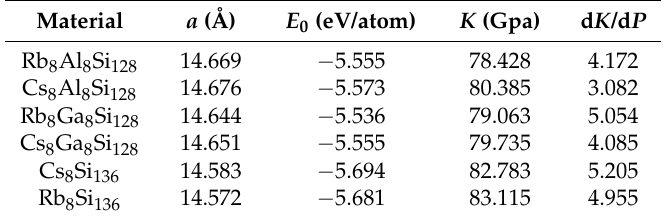
The equation of state (EOS) parameters obtained for the filled ternary